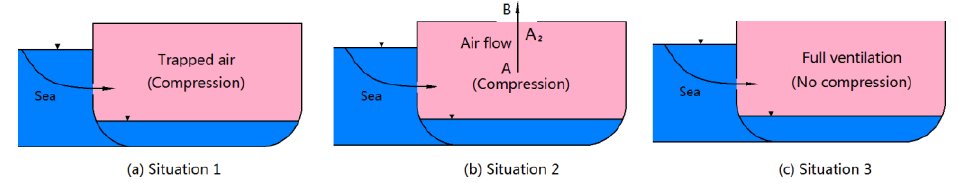
Figure 1. Generic cases with air compression and air escape.